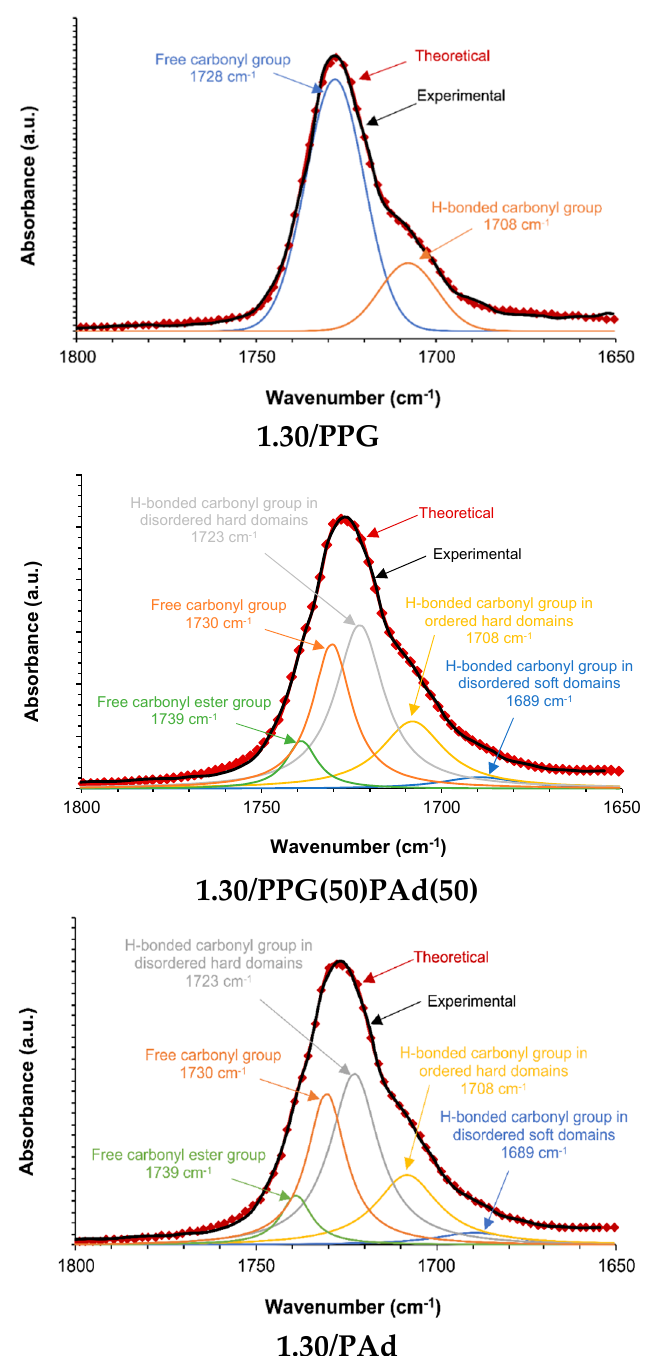
Figure 4. Curve fitting of the carbonyl region of the ATR-IR spectra of 1.30/PPG, 1.30/PPG(50)PAd(50) and 1.30/PAd. The term “theoretical” was used to describe the curve fitted spectra by using Gaussian function.